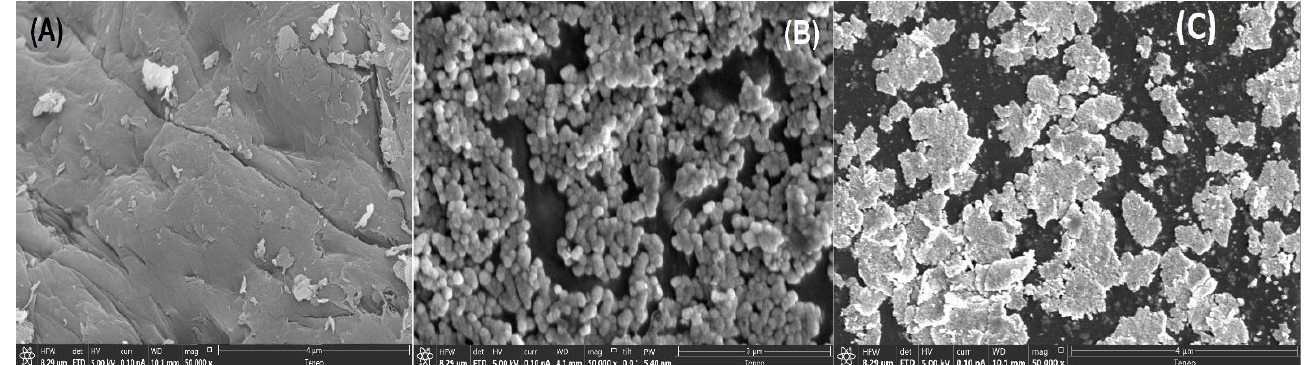
Figure 2. Comparative FTIR spectra of chitosan (A) and chitosan-strontium oxide nanocomposite (B) (10 wt.%).